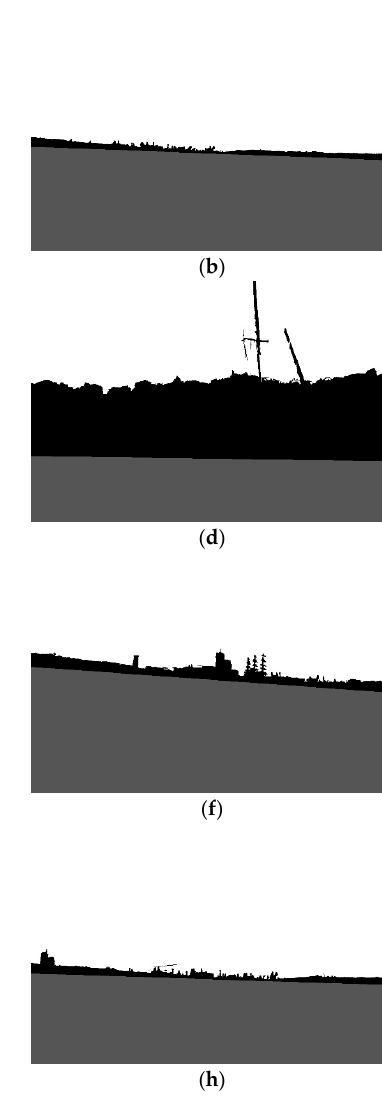
Figure 15. Results of land segmentation ( a,b ) The object presented in the sea area; ( c,d ) The object presented in the land area; ( e,f ) The shoreline does not expand to the whole image; ( g,h ) Partial segmentation due to the clouds. segmentation due to the